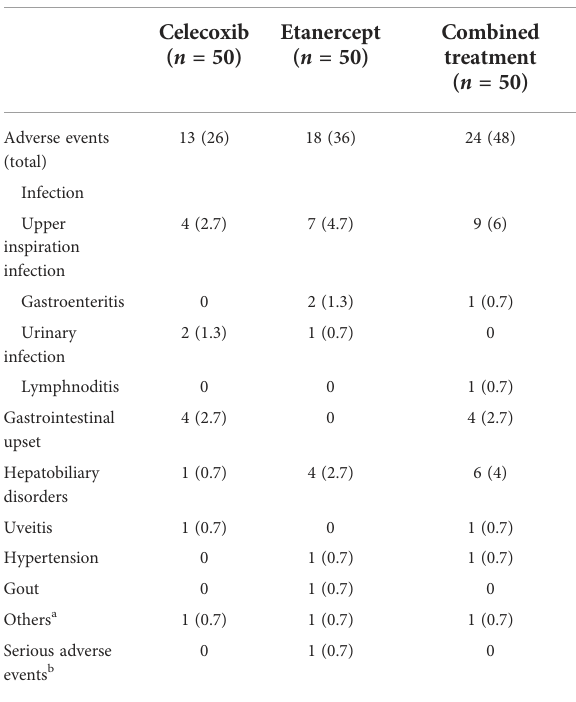
TABLE 3 Adverse